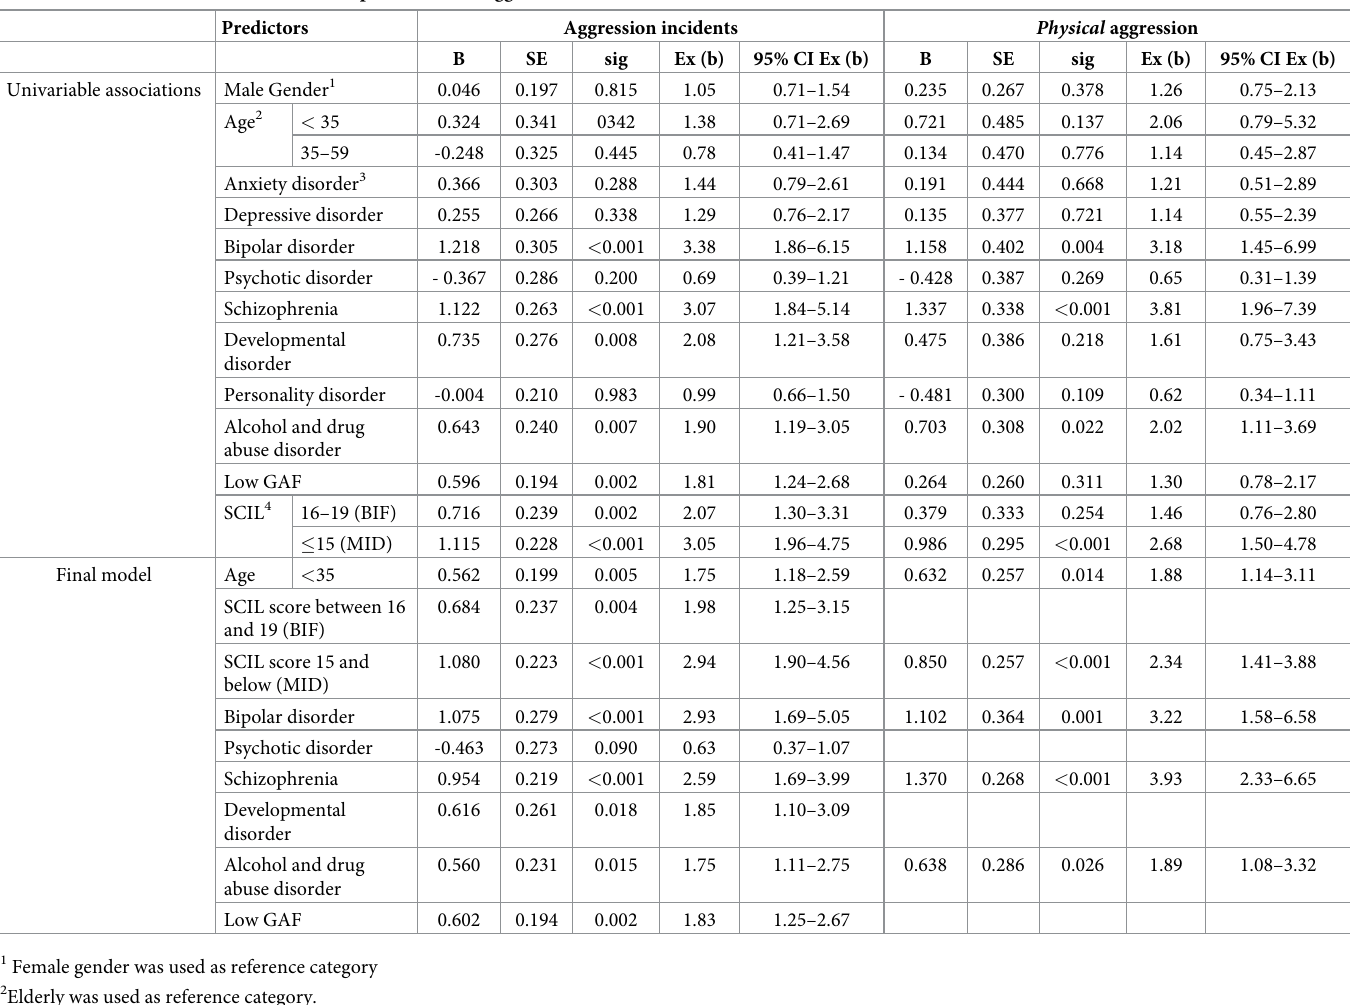
Table 3. Multivariable association between predictors and